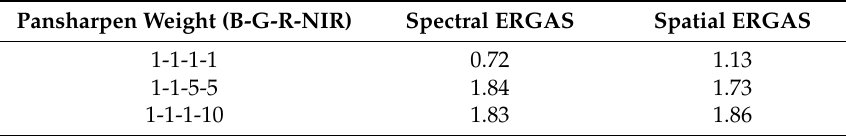
Table 2. Spectral and spatial indexes to control the quality of the pansharpened